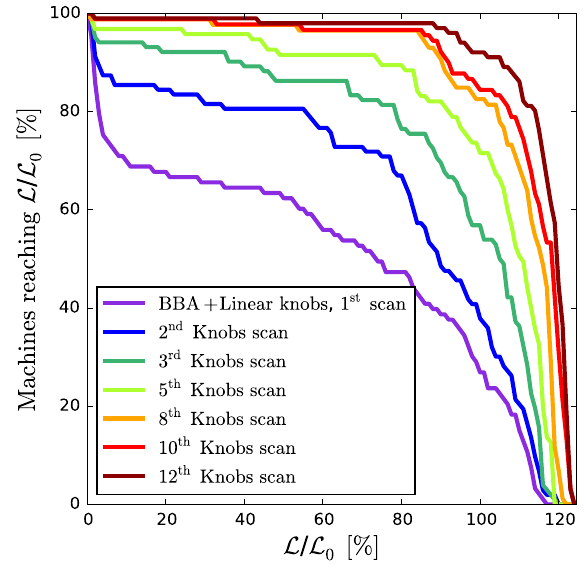
FIG. 10. Tuning performance results for the optimized L (cid:1) ¼ 6 m design with β (cid:1) ¼ 0 . 12 mm. 87% of the machines y achieve at least 110% of the design luminosity after 12 iterations of linear knobs, corresponding to approximately 5000 luminosity